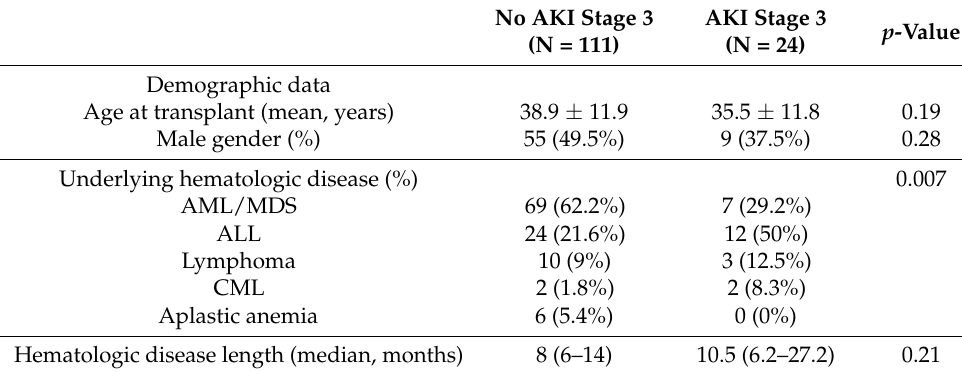
Figure 2. Kaplan–Meier curves showing cumulative risk of AKI according to the presence of CsA overdosage ( A ), TAC overdosage ( B ), mixed GVHD ( C ) and CRP value ( D ). Table 3. Clinical, laboratory, transplant characteristics, and complications of the study patients according to AKI stage